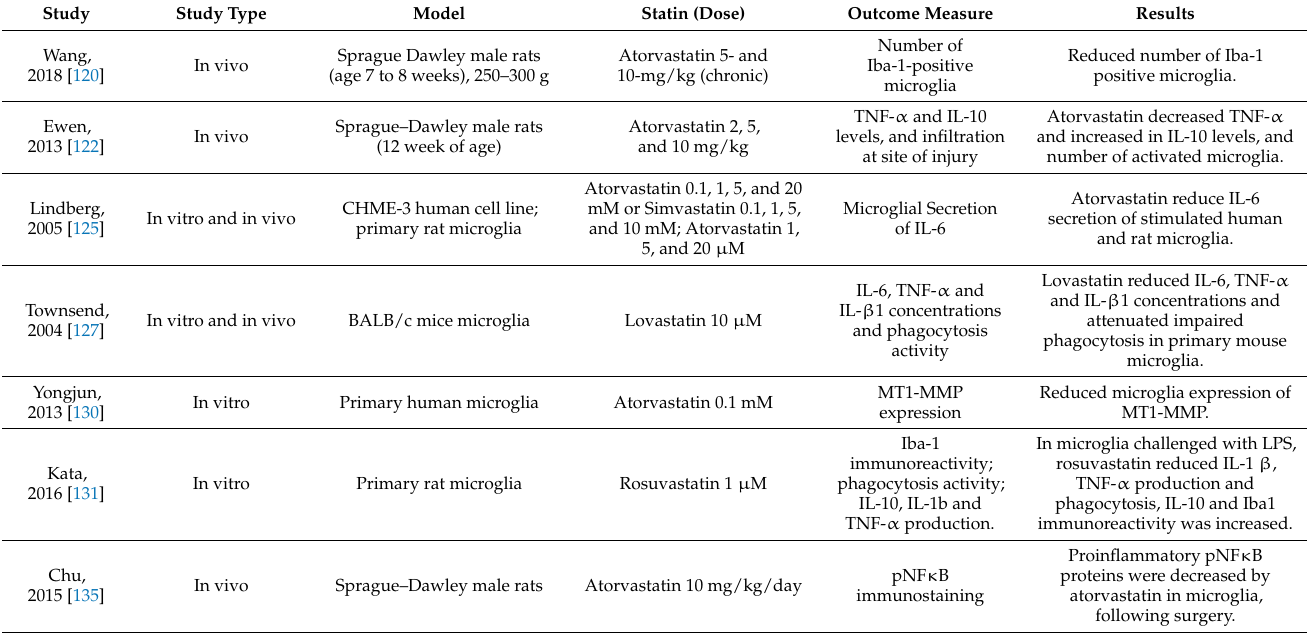
Table 1. Summary of studies highlighting the effects of statins on